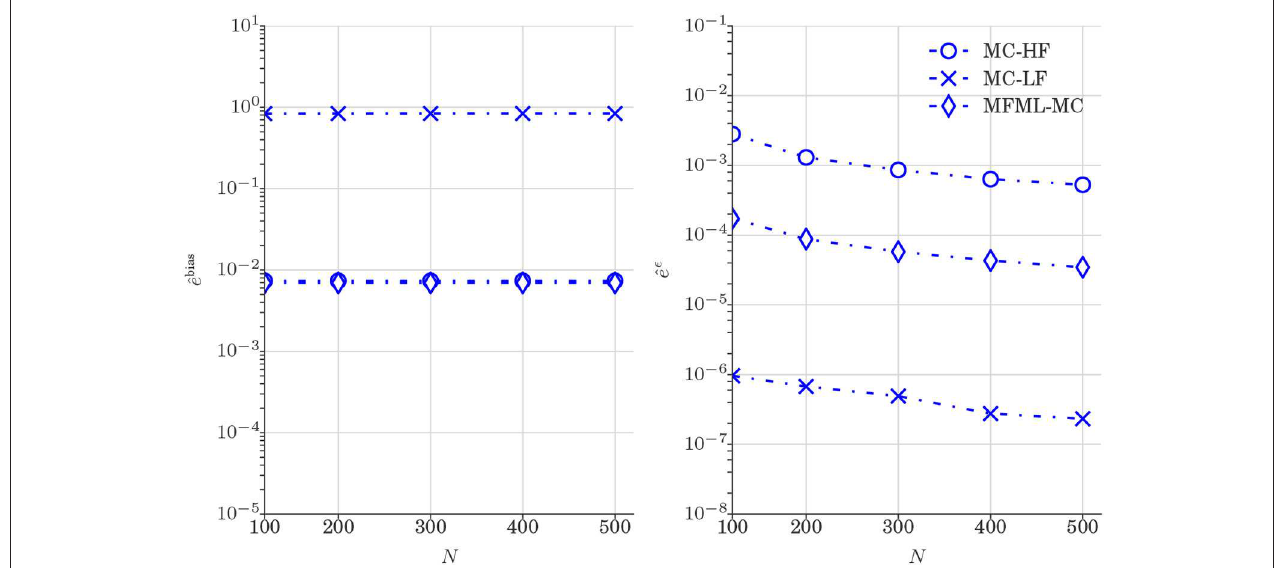
e bias and e ǫ (Equation 25) estimation of E [ u ] (water saturation field at 6 ˆ ˆ [1,2,3,4,5] 10 2 , where p is the number of MC realizations N that uses only high-fidelity model. = ×